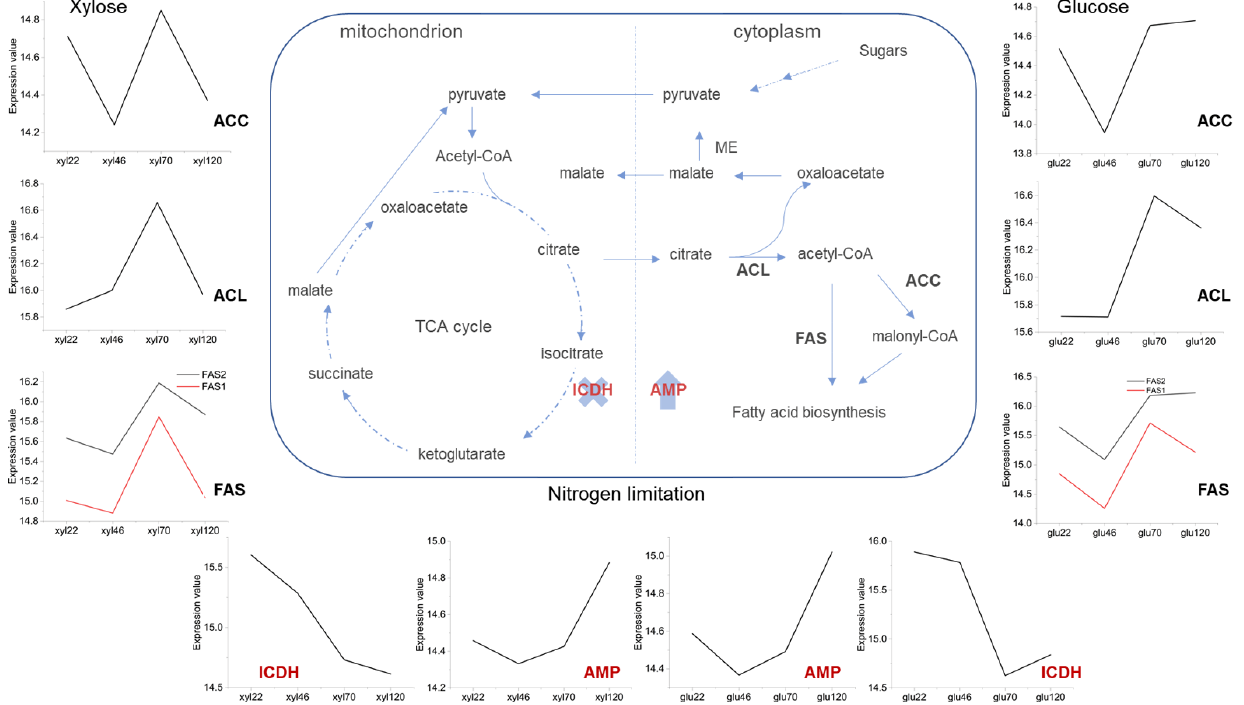
Figure 6. Profiles of major genes linked to initiation and production of single cell oil during growth of Saitozyma podzolica DSM 27192 on glucose and xylose under nitrogen limitation. ACC, ACL, AMP, FAS and ICDH refer to acetyl-CoA carboxylase, ATP citrate lyase, AMP deaminase, fatty acid synthase and isocitrate dehydrogenase respectively. Line graphs show expression trajectories of genes encoding ACC, ACL, AMP, FAS and ICDH. X and arrow up indicate suppression of ICDH and overexpression of AMP.